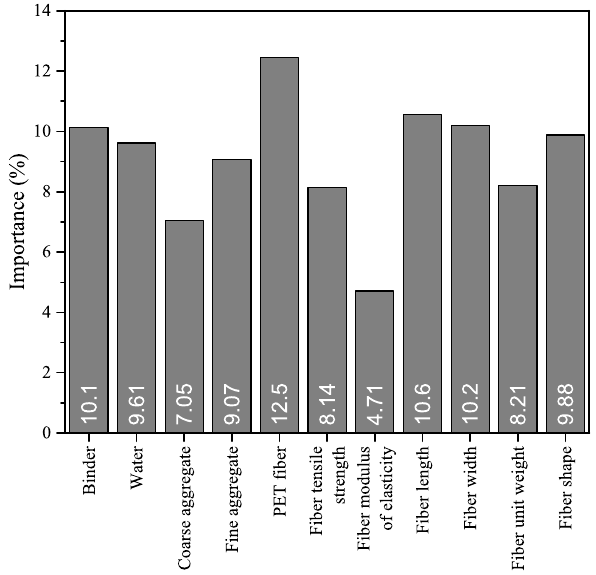
Figure 5. Relative importance of the input parameters in the proposed